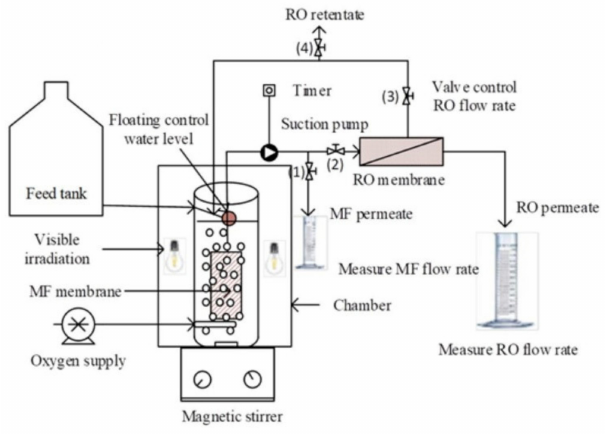
Figure 7. Schematization of the continuous SPMR+RO system used by Nguyen et al. Reprinted with permission from ref. [41]. Copyright © 2021 Institution of Chemical Engineers. Published by